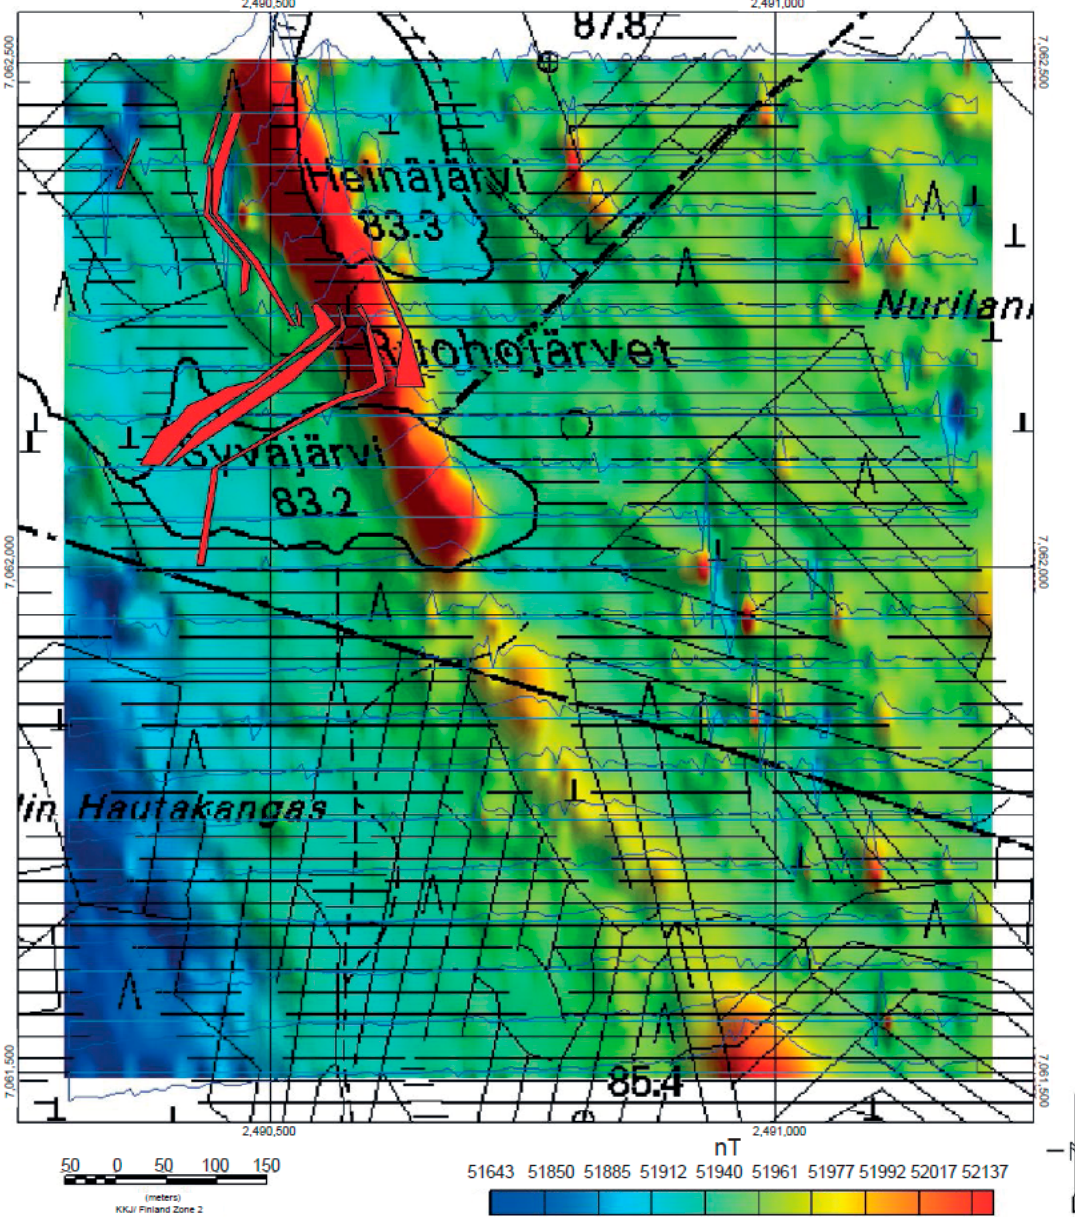
Figure 12. Ground magnetic map of the Syväjärvi exploration area, Kaustinen Li pegmatite Province. Modified from Ahtola et al. (2015) [56]. The blue lines show the magnetic profiles, whereas the red polygons mark the spodumene pegmatite. The positive magnetic anomaly (red colour) is caused by intermediate volcanic rocks. Basemap © National Land Survey of Finland, license number MML/VIR/TIPA/217/10.